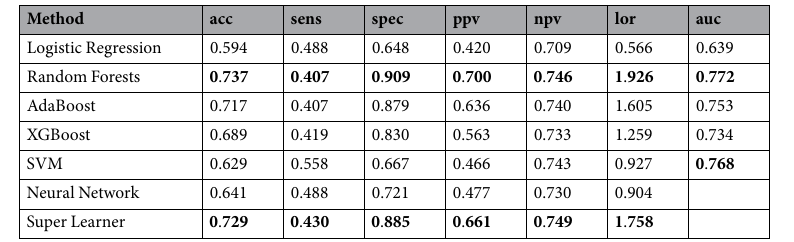
Table 19. Performance of model-based and model-free methods (using selected features) for Tel-Aviv dataset to predict no fall or at least two falls, contrast to results in Table 11 (falls/no-fall).